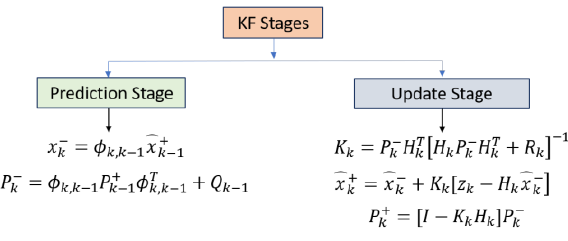
Figure 17. Kalman Filter prediction and update stages equations.